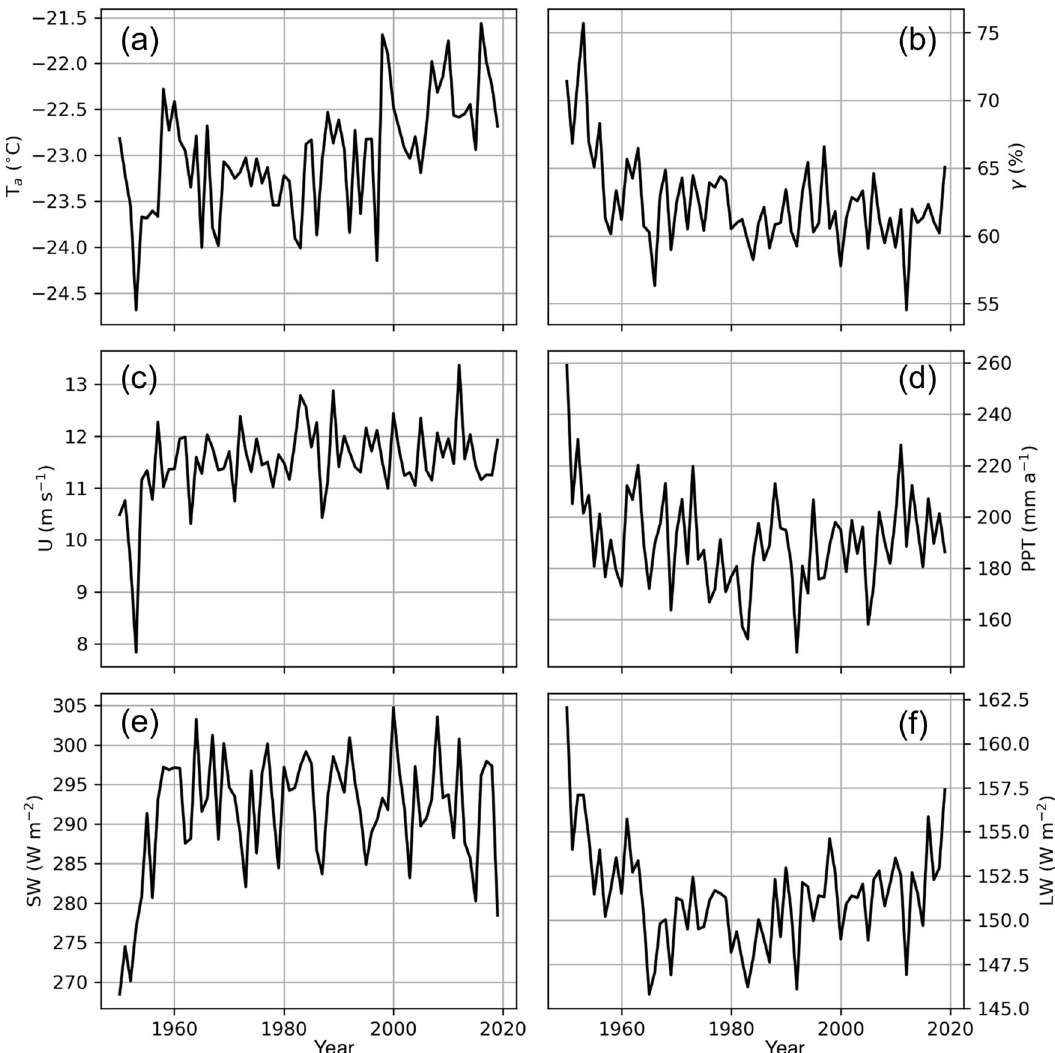
Fig. 4 Meteorology time-series. Annual means for meteorological variables downscaled to SCG. See Methods section for details of the downscaling. Panel a : T a is air temperature ( T a ) panel b is relative humidity ( γ ), panel c is wind speed ( U ), panel d is precipitation (PPT), panel e is incident shortwave radiation (SW), and panel f is incident longwave radiation